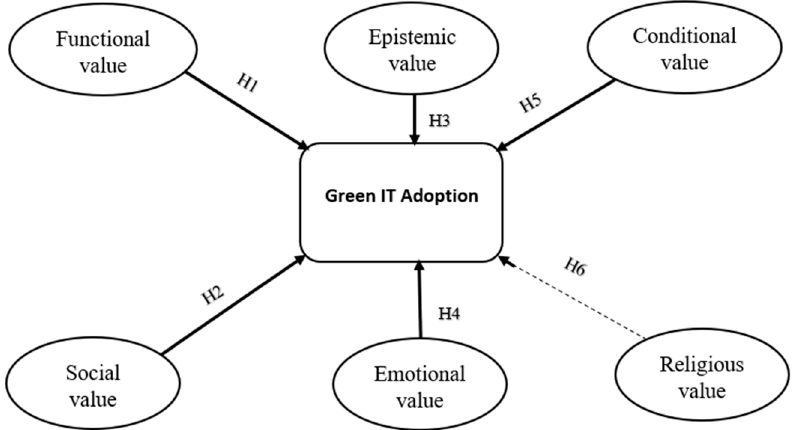
Figure 1. Theoretical framework.